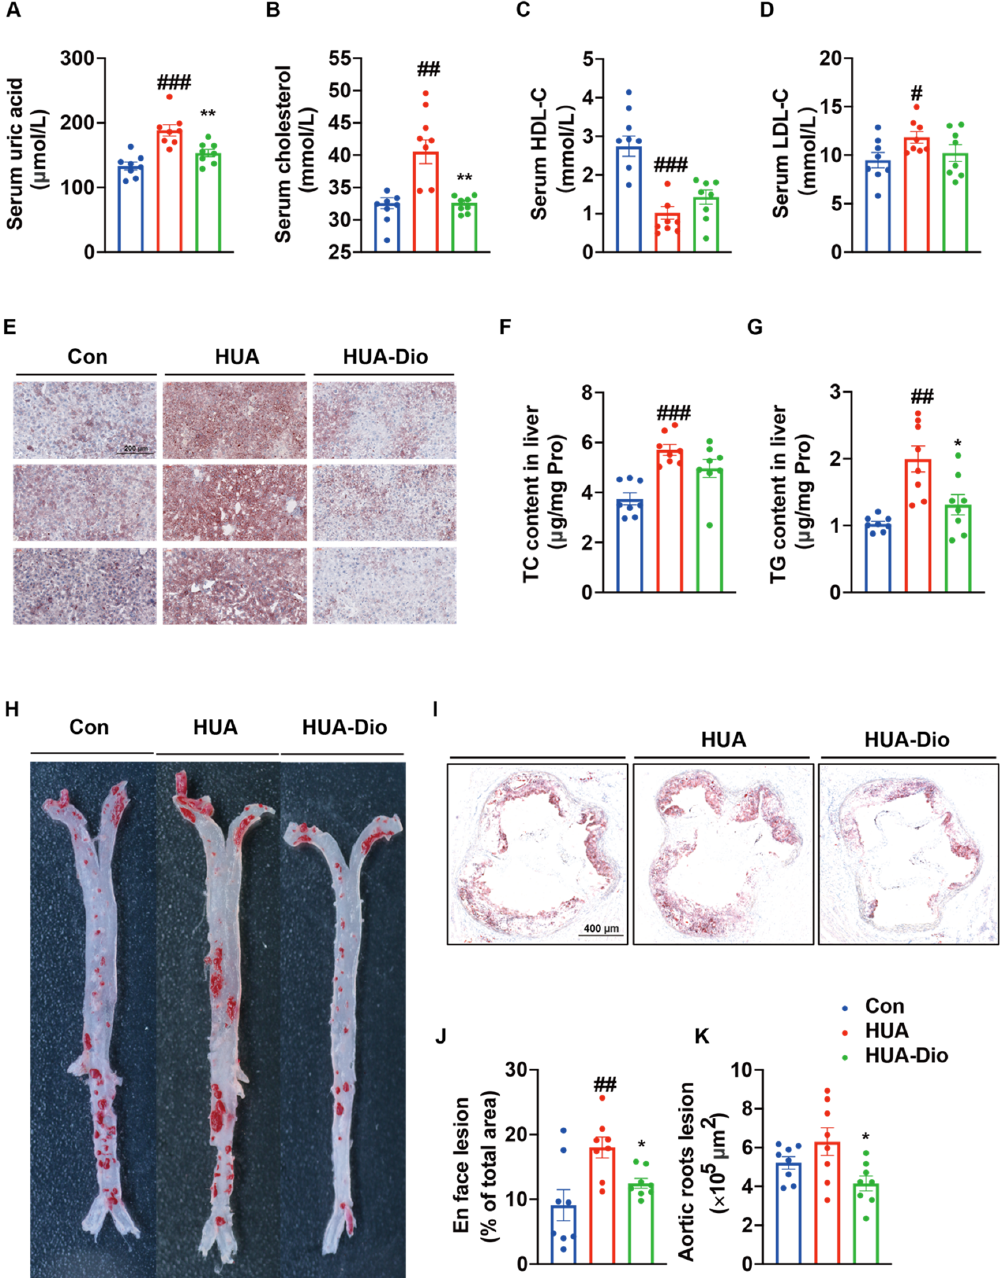
Figure 2. Dioscin alleviated hyperuricemia-aggravated atherosclerosis and dysfunction of cholesterol metabolism in ApoE − / − mice. Control ApoE − / − mice group (Con), hyperuricemic ApoE − / − mice group (HUA), dioscin treatment hyperuricemic ApoE − / − mice group (HUA-Dio). ( A ) Serum uric acid level. ( B ) Serum cholesterol level. ( C ) Serum HDL-C level. ( D ) Serum LDL-C level. ( E ) Oil Red O staining in the livers of mice. ( F ) TC contents in liver. ( G ) TG contents in liver. ( H ) Oil Red O staining of en face aortal lesion. ( I ) Oil Red O staining of lesion area in aortic root. ( J ) Quantification of en face aortal lesion. ( K ) Quantification of lesion. Data are presented as mean ± S.E.M. # p < 0.05, ## p < 0.01, ### p < 0.001 vs. control ApoE − / − mice group; * p < 0.05, ** p < 0.01 vs. hyperuricemic ApoE − / − mice group. Compared with the control ApoE − / − mice, there was no significant change in the contents of serum total bile acid (TBA), unconjugated bile acid (UBA), and conjugated bile acid (CBA) in the hyperuricemic ApoE − / − mice (Figure 3A,D). The contents of